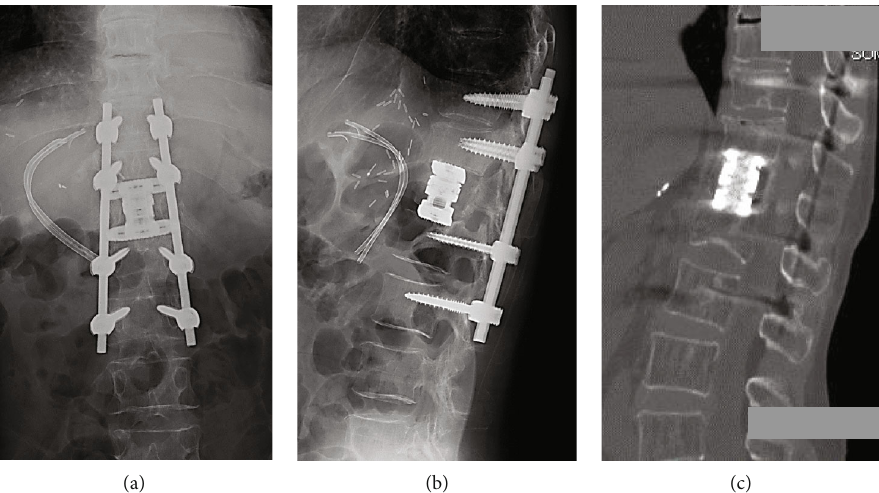
Figure 6: Postoperative radiographs and computed tomography (CT) images of the thoracolumbar spine of a 66-year-old woman with collapse of the 12 th thoracic (T12) vertebra. (a) anteroposterior view X-ray; (b) lateral view X-ray; (c) sagittal CT image two years following